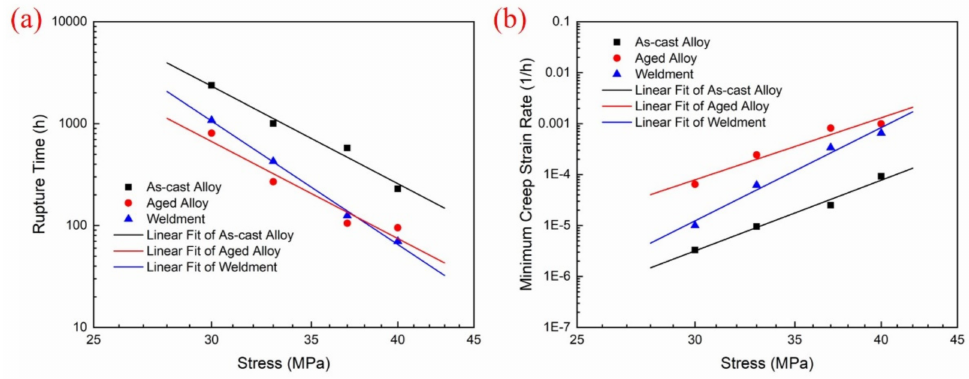
Figure 11. Stress dependence of ( a ) rupture time and ( b ) minimum creep strain rate at 950 ◦ C for the as-cast alloy, aged alloy, and fresh-to-aged welded joint.